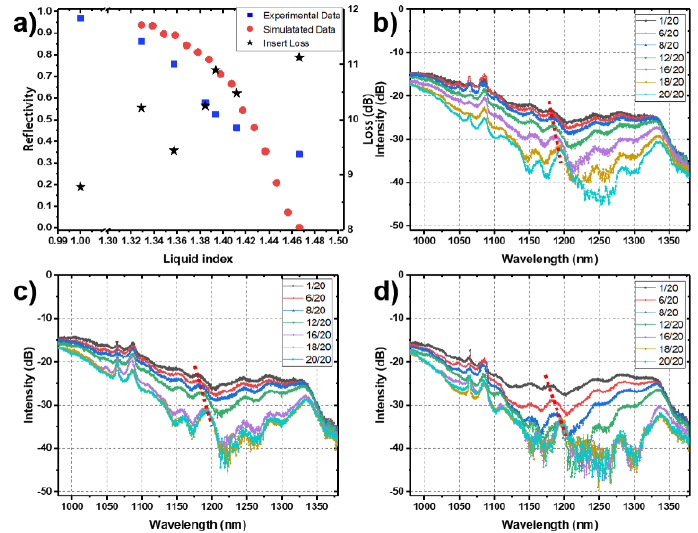
Figure 4. ( a ) Response of the device to 808 nm light. The blue squares represent the experimental test values, and the red dots represent the Rsoft simulation results. The black stars represent the device loss. ( b – d ) Spectral response of the device under different polishing depths (0.5 µ m, 1 µ m, and 1.5 µ m, respectively); the lines of different colors represent the spectral response of the device to different refractive index matching solutions. (Refractive index matching liquid was made up of different proportions of water and glycerol; 1/20 means that the mixing ratio of water and glycerol was 1:19.) The dotted line in the figure indicates a group of spectral peaks that move with the change in refractive index .